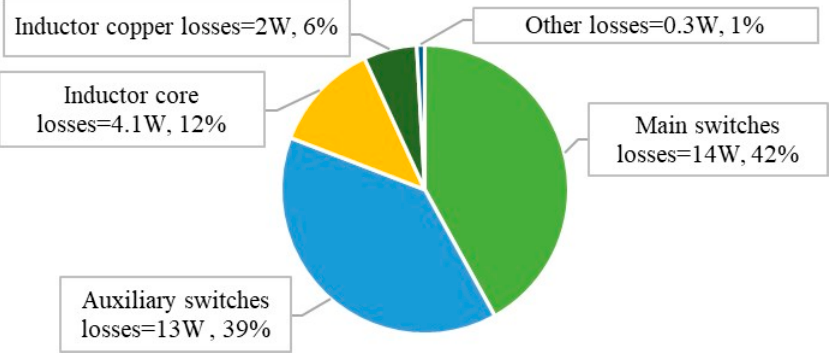
Figure 25. Calculated loss